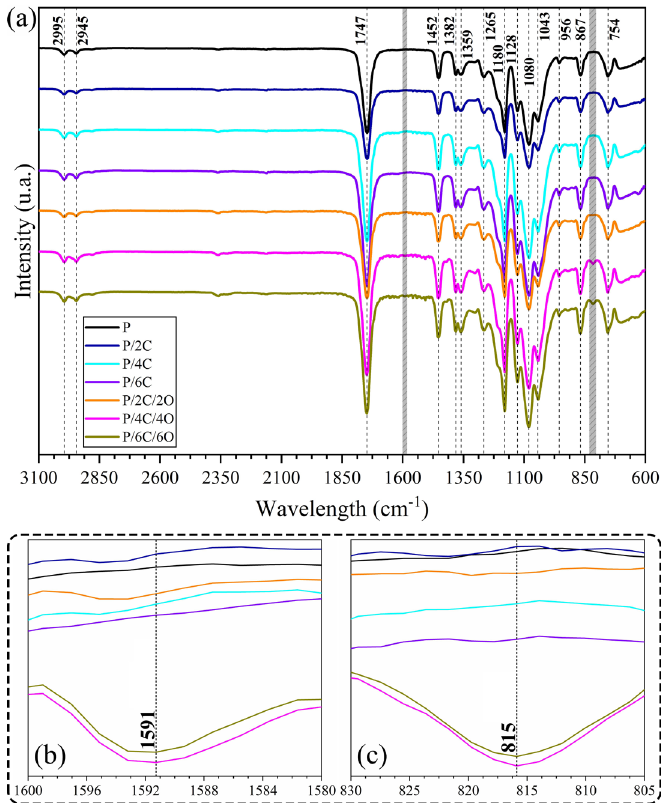
Figure 1. FTIR spectra of the films produced: (a) bands in the 3100–600 cm -1 region; (b) emphasis on the bands in the 1600–1580 cm -1 region and (c) 830–805 cm -1